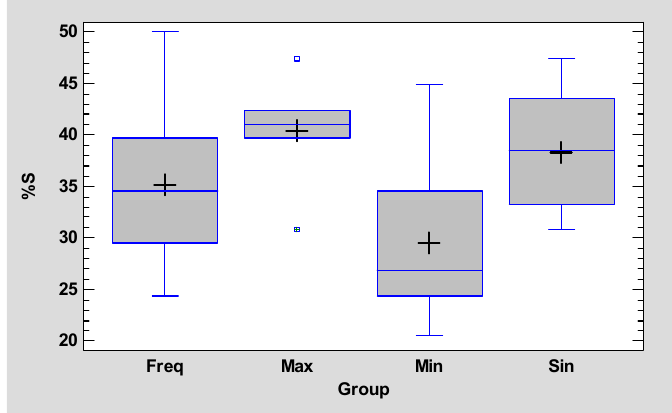
Figure 4. Box chart for %S according to Group.